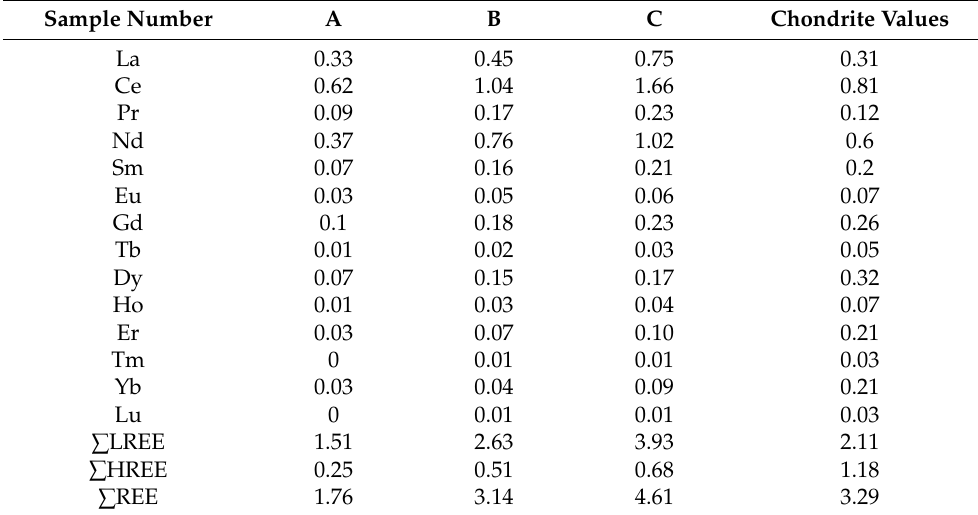
Table 9. Analysis results of rare earth elements in the Mayuan Zn-Pb deposit (ppm). Sample